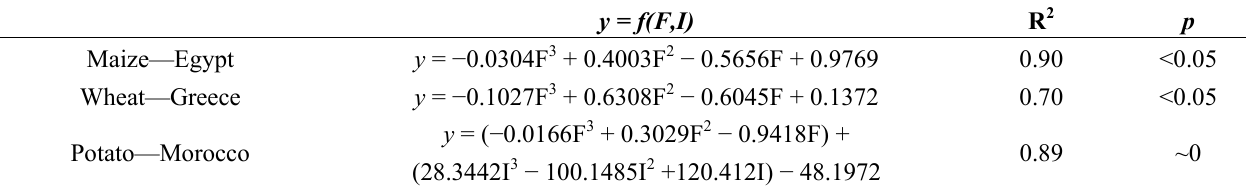
Table 2. Statistical relationships between crop yield and crop managements (fertilizer and Irrigation applications) for the three case studies. y , F and I refer to crop yield, total fertilizer consumption and irrigation, respectively (see text for details). y expresses the crop yield difference between any given year and the initial year ( i.e ., year 1961), while F and I is the ratio of fertilizer consumption and Irrigation, respectively, between any given year and the initial year. R is the correlation coefficient and p is the two-tailed t -test value. The relationship is statistically significant at the 95% confidence limit when p is lower than